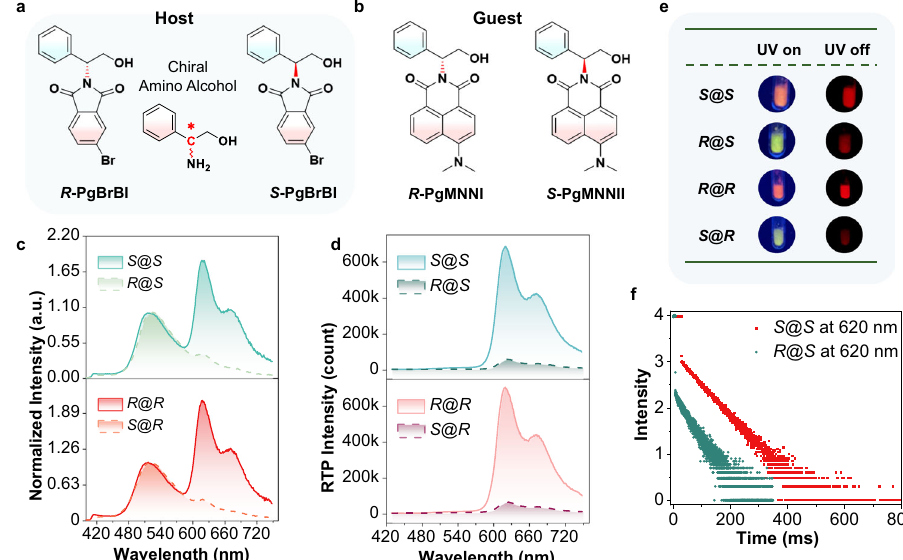
Fig. 4 | Chiral amino alcohol recognition with CPE. a , b Molecular structures of chiral amino alcohol derivatives: chemically modi fi ed chiral analyte guests ( b , R - PgMNNI and S -PgMNNI ) and chiral selector hosts ( a , R -PgBrBI and S -PgBrBI ) molecules. c Normalized steady-state PL spectra of two chiral guests ( w / w =100 ppm) in two chiral host solids (for example, R @ R represents R -PgMNN I@ R -